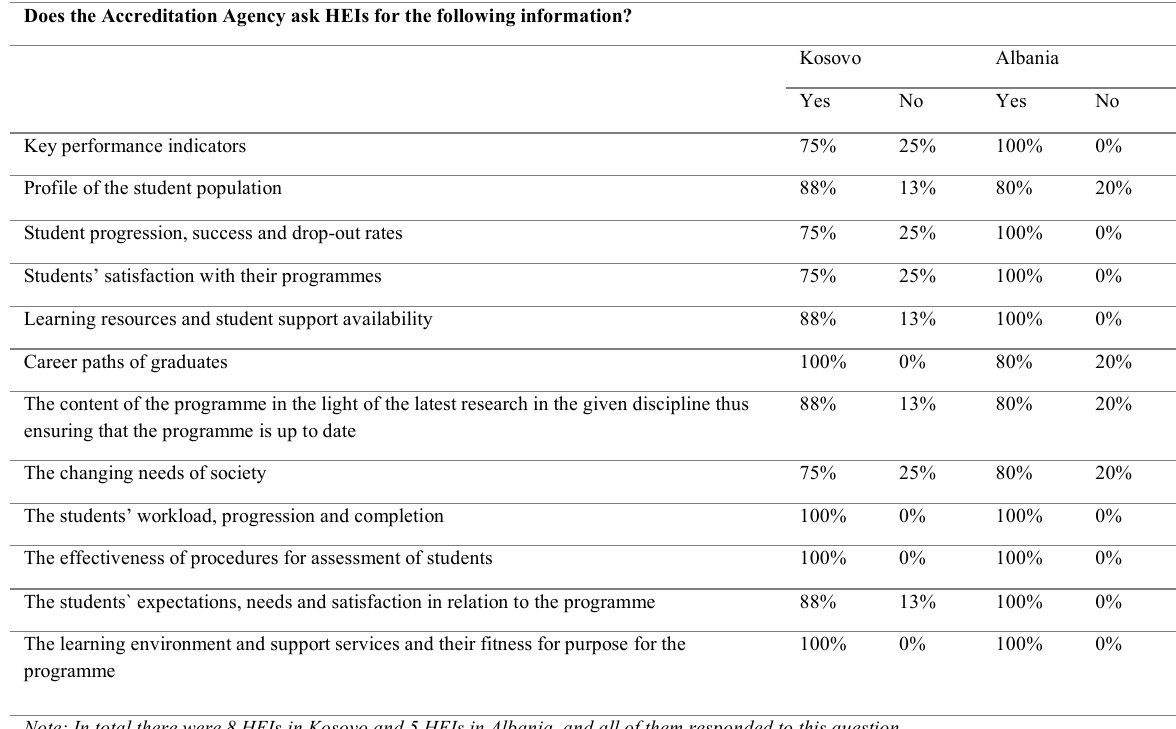
Table 7 : Internal quality assurance: Information Management in regarding the Kosovo and Albania